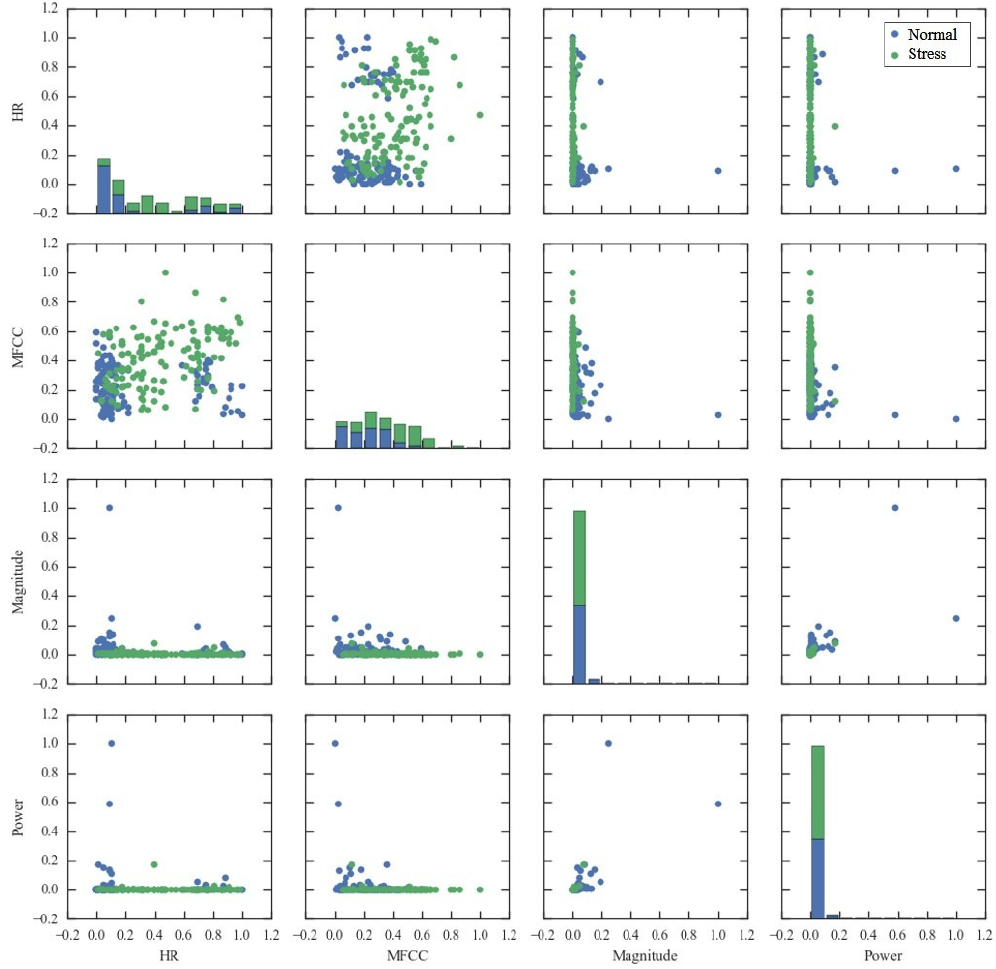
Figure 6. Scatter matrix of four selected features which appear most frequently among the feature selection results by the three methods (CHI, IG, and SVMW). HR: heart rate; Magnitude: magnitude spectrum overall average; MFCC: MFCC overall standard deviation; Power: power spectrum overall